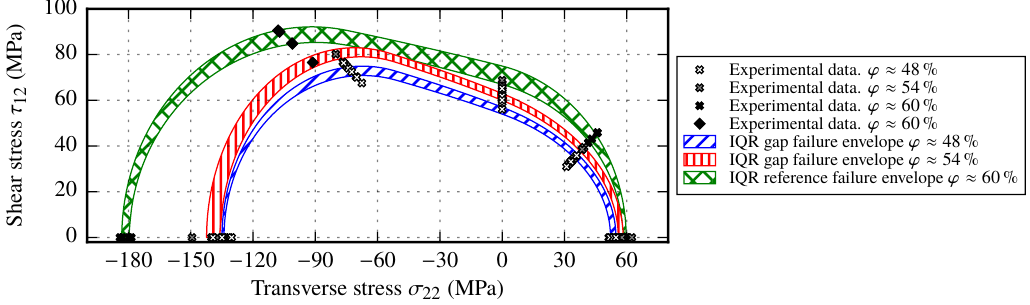
Figure 22. Resulting failure envelope ranges for samples with gaps at ϕ ≈ { 48%,54% } compared to the reference samples failure envelope at ϕ ≈